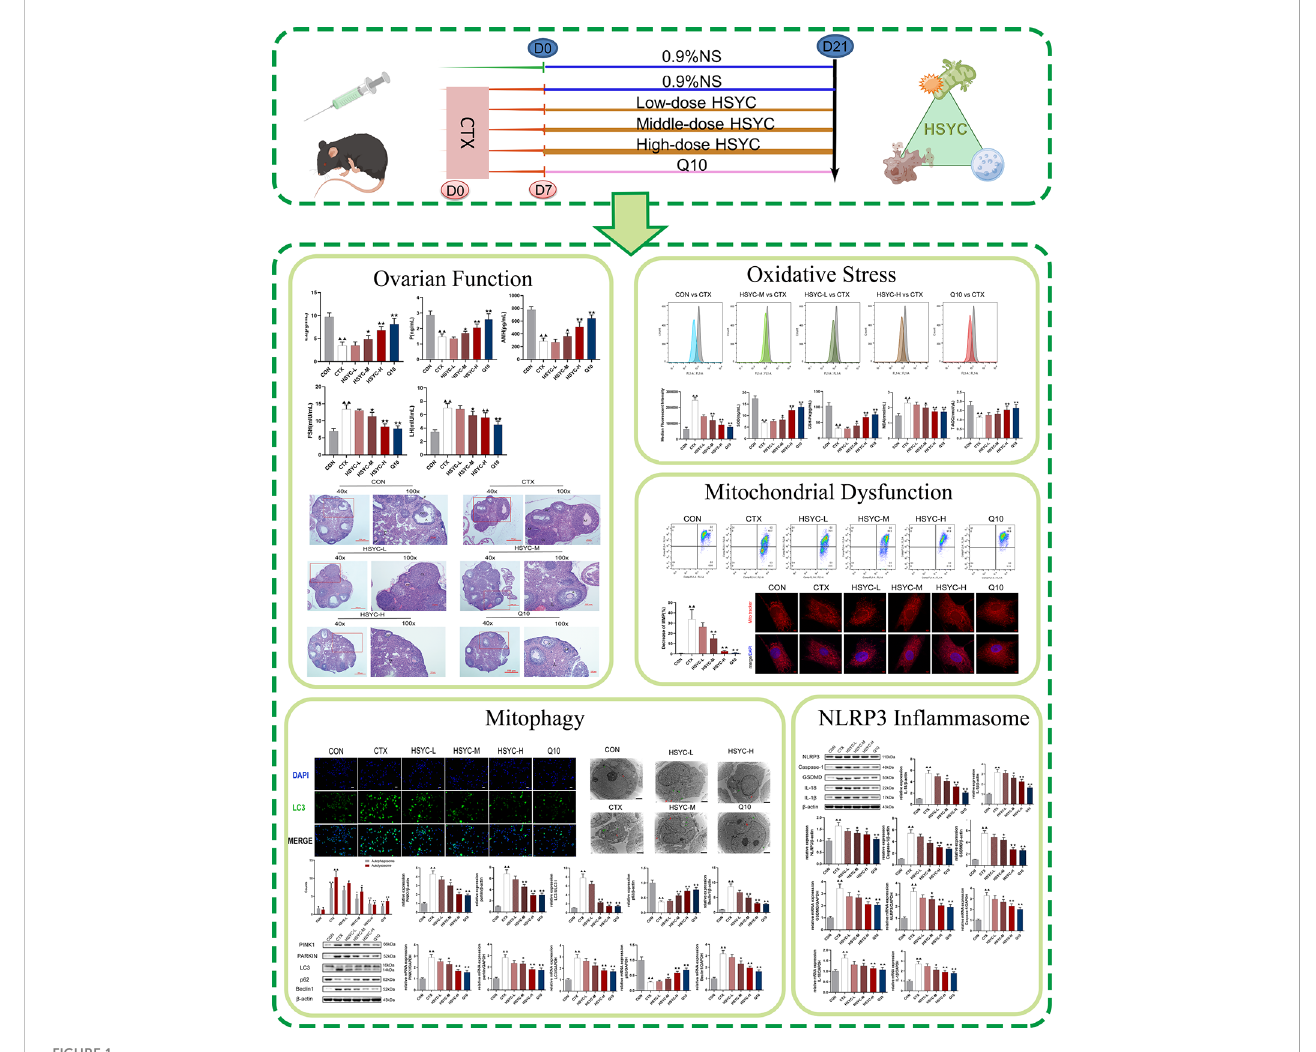
FIGURE 1 The fl owchart of this